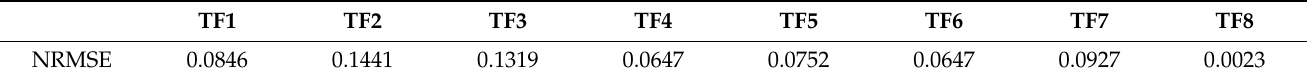
This second method to apply transfer function models on different datasets was to average all the datasets together into one dataset before applying the transfer function DARX. These results are shown in Figure 9 and Table 11.